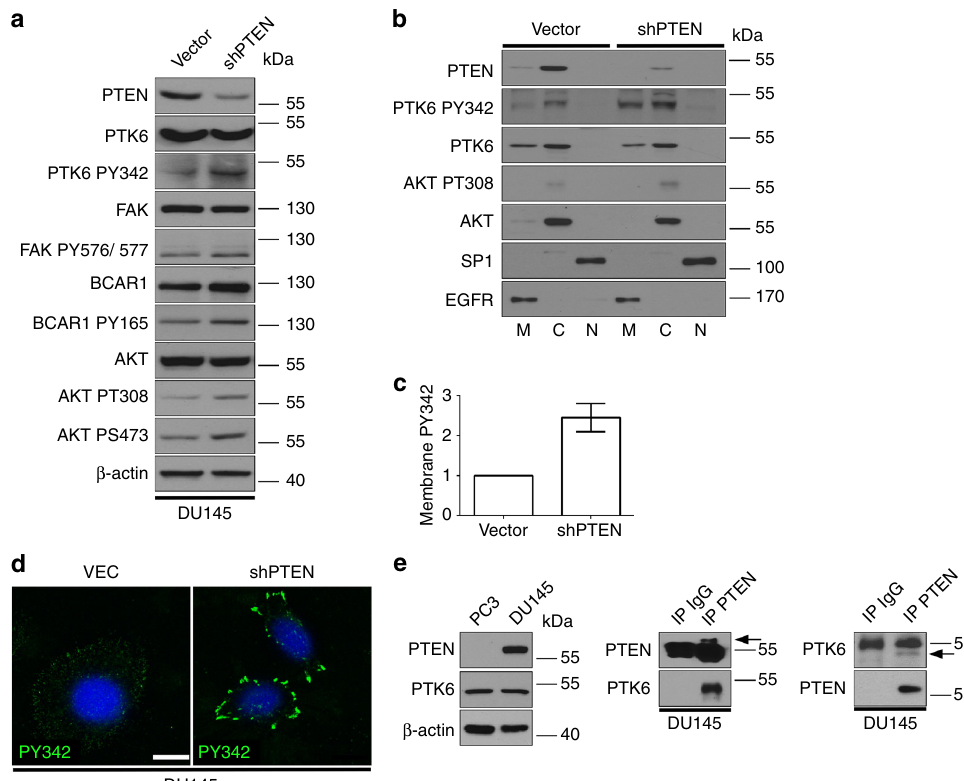
Fig. 2 Knockdown of PTEN in DU145 cells activates PTK6. a DU145 prostate cancer cells were subjected to stable PTEN knockdown by shRNA. Total cell lysates were prepared from DU145 cells with empty Vector or the PTEN shRNA construct (shPTEN). Activation of PTK6 and BCAR1 and FAK, direct targets of PTK6, were monitored by immunoblotting. b DU145 cells expressing empty vector or the shRNA targeting PTEN were fractionated into membrane, cytoplasmic, and nuclear compartments and activation of PTK6 was assessed by immunoblotting. SP1 and EGFR were examined as nuclear and membrane markers, respectively. c Relative changes in activation of PTK6 at the plasma membrane were quanti fi ed by ImageJ ( n = 3). d DU145 cells stably expressing the shRNA targeting PTEN were examined for activation of PTK6 (PY342, green) by immuno fl uorescence. Cells were counterstained with DAPI (blue). Scale bar, 10 µ m. e PTEN status in PC3 and DU145 cells was con fi rmed by immunoblot. PTEN and PTK6 were immunoprecipitated with speci fi c antibodies or non-speci fi c IgG from the same species. Arrowheads point to immunoprecipitated protein. Dark background signal is